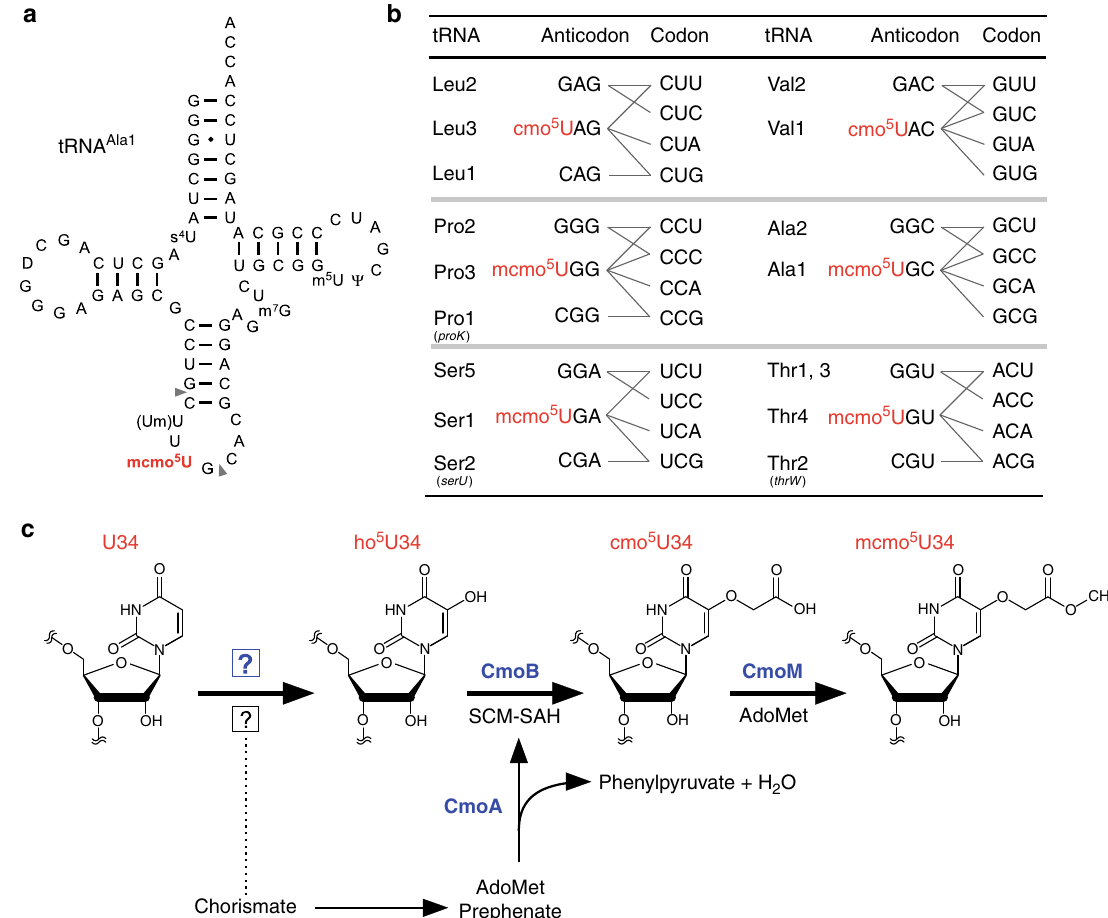
Fig. 1 Decoding capacity of tRNAs is expanded by (m)cmo 5 U. a Secondary structure of E. coli tRNA Ala1 with post-transcriptional modi fi cations: 4- thiouridine (s 4 U), dihydrouridine (D), 2 ’ - O -methyluridine (Um), 5-methoxycarbonylmethoxyuridine (mcmo 5 U), 7-methylguanosine (m 7 G), 5- methyluridine (m 5 U), and pseudouridine ( Ψ ). A pair of gray triangles indicate the RNase T 1 cleavage positions for analysis of RNA fragments containing the wobble position. b Anticodon – codon pairing in six codon boxes decoded by tRNAs bearing cmo 5 U and mcmo 5 U. Each of the three tRNA genes in parenthesis was individually deleted. In the family boxes (four codons specify a single amino acid), many codons are redundantly decoded by two or three isoacceptors (tRNAs charging with the same amino acid). For example, CUU codon is decoded by tRNA Leu2 with GAG anticodon as well as tRNA Leu3 with cmo 5 UAG anticodon. c Scheme of mcmo 5 U biosynthesis in E. coli . First, U34 is hydroxylated by reactions involving unknown enzymes and substrates to form ho 5 U34 in tRNAs responsible for decoding NYN codons. This reaction requires the chorismate biogenesis pathway. CmoA employs prephenate and AdoMet to generate SCM-SAH with the release of phenylpyruvate and water. Then, ho 5 U34 is carboxymethylated by CmoB using SCM-SAH. Finally, tRNAs responsible for decoding NCN codons are further methylated to generate mcmo 5 U by CmoM in the presence of